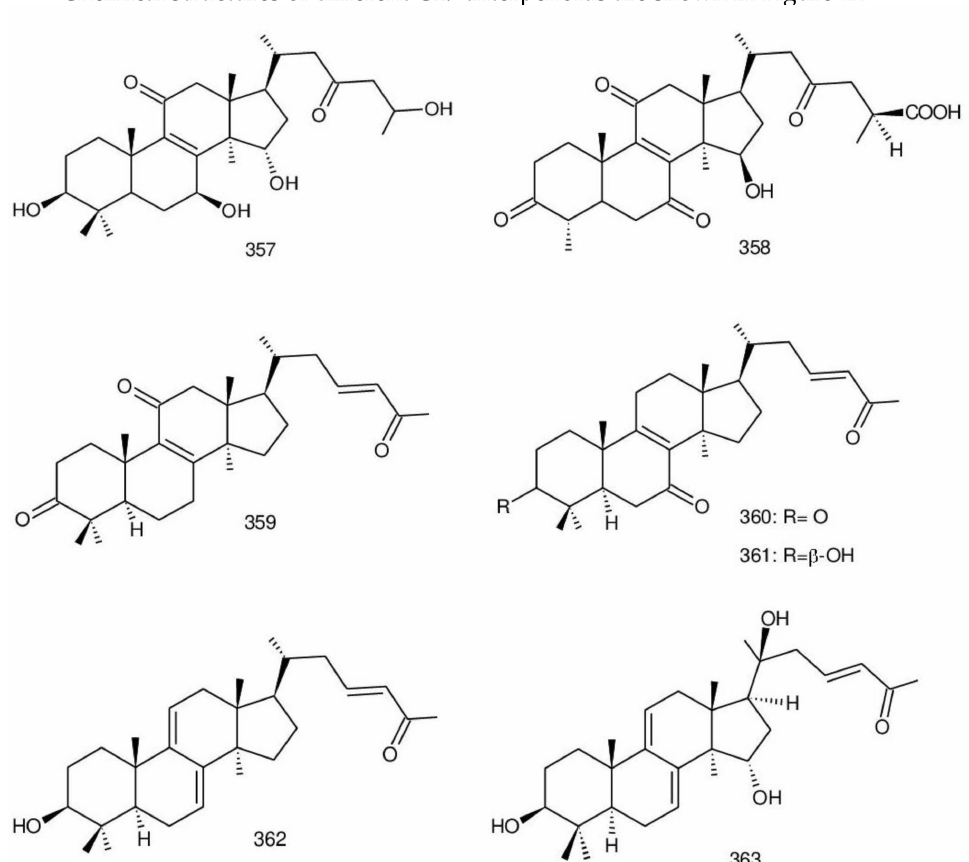
Figure 12. Chemical structures of several C29 triterpenoids ( 357 – 363